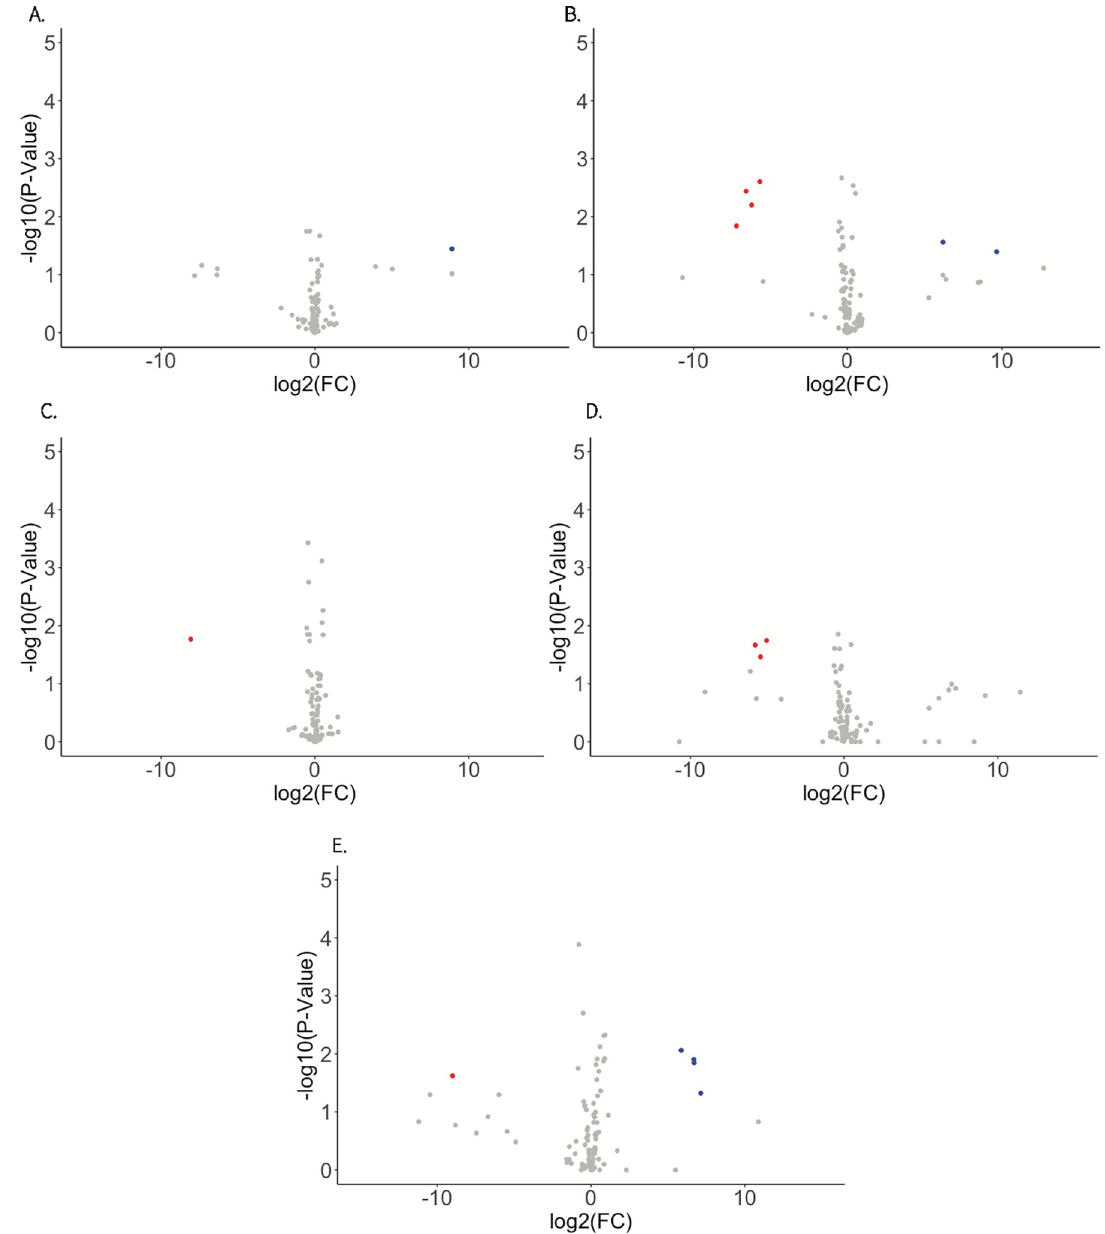
Fig 7. Volcano plots visualizing differential expression of identified An . stephensi miRNAs in response to Mayaro infection. The Y- axis shows -log10 transformed P-values, and the X-axis shows log2 transformed fold change values. Red points represent transcripts depleted by more than -1 log2FC in response to infection with a FDR < 0.05, while blue points are transcripts enriched by more than 1 log2FC in response to infection with a FDR < 0.05. A.—C. are the 2 dpi, 7 dpi, and 14 dpi groupings respectively, while D. and E. are miRNAs regulated in the infected treatment between 2–7 dpi and 7–14 dpi